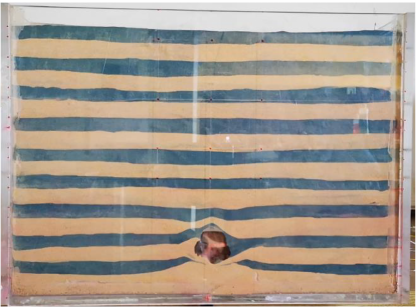
Figure 5. Very well compacted sand fill, at a 100% volume reduc- tion (photo taken by Jeandre Labuschagne).